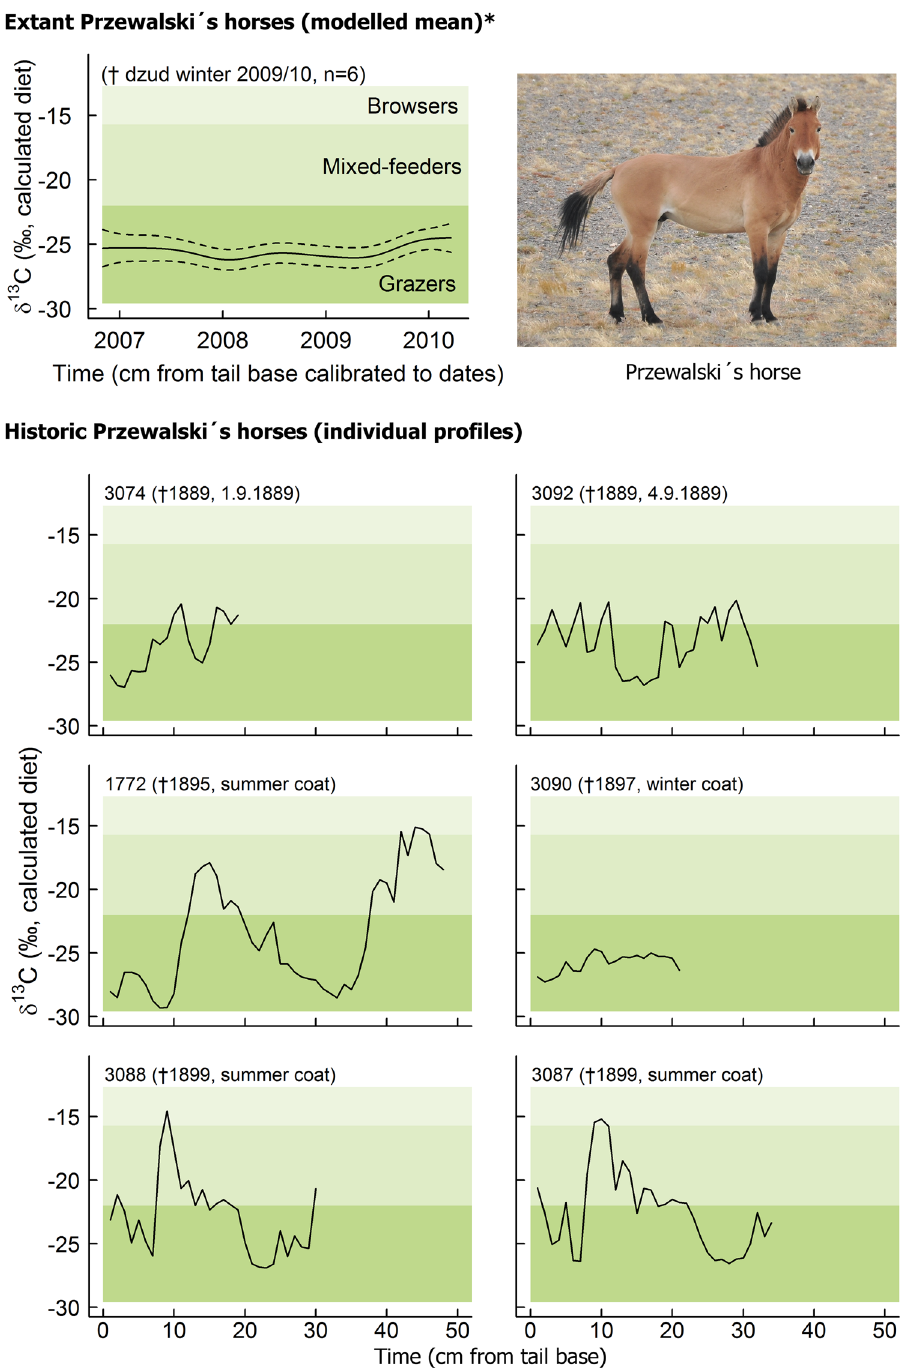
Figure 2. Carbon isotope ( δ 13 C diet ) profiles of reintroduced, extant and historic Przewalski’s horses in the Dzungarian Gobi. Photo: P.